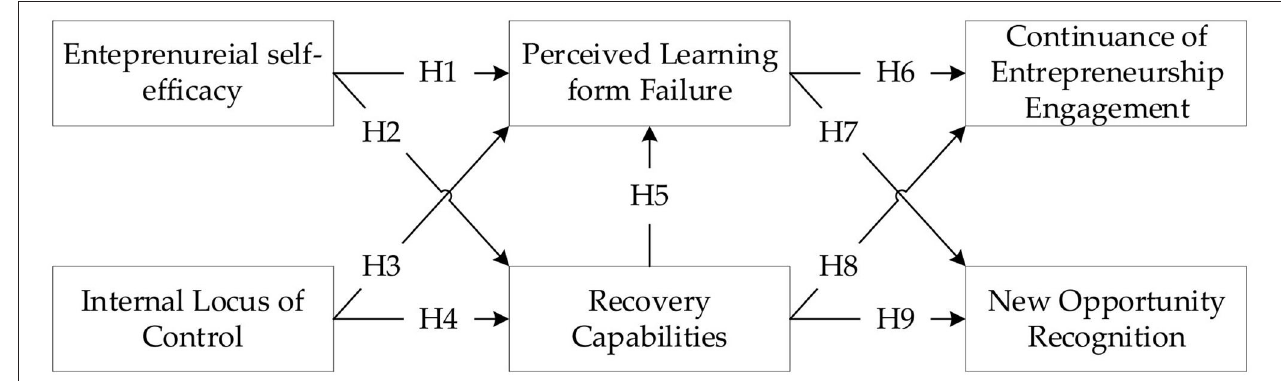
FIGURE 1 | Research